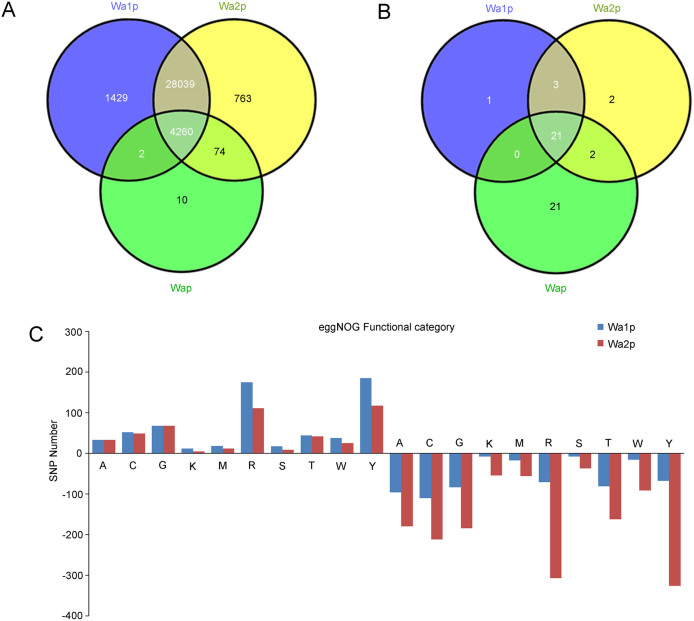
Venn Diagramed cSNP statistics in different groups (A) and number of SNPs in differential expressed genes belonging to different functional categories (B).(A): RNA processing and modification; (C): Energy production and conversion; (G): Carbohydrate transport and metabolism; (K): Transcription; (M): Cell wall/membrane/envelope biogenesis; (R): General function prediction only; (S): Function unknown; (T): Signal transduction mechanisms; (W): Extracellular structures; (Y): Nuclear structure; (Z): Cytoskeleton.